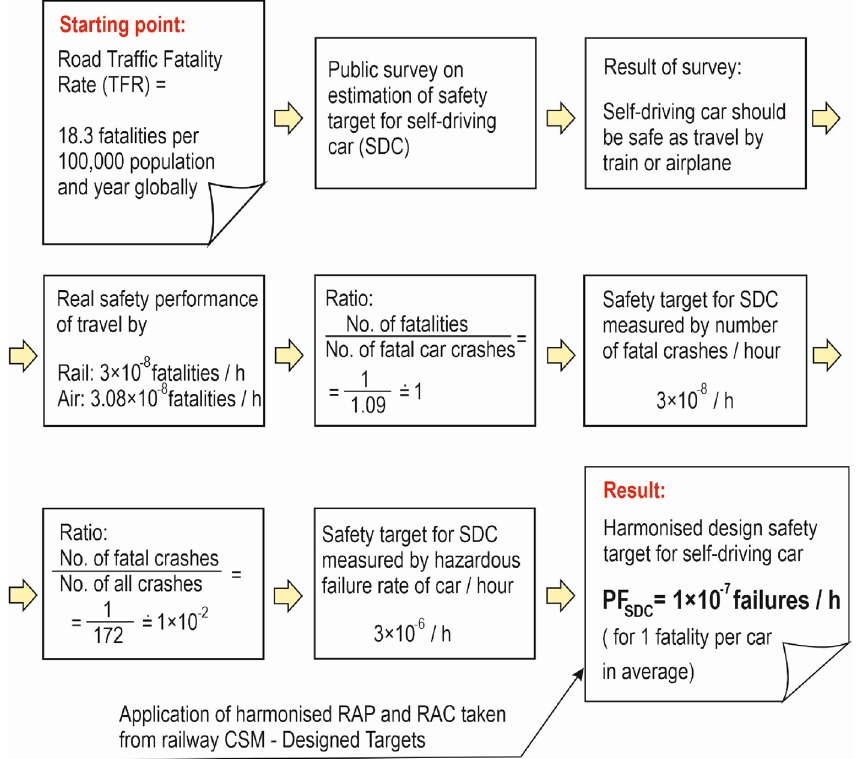
Figure 4. Procedure for derivation of harmonised design safety target for self-driving